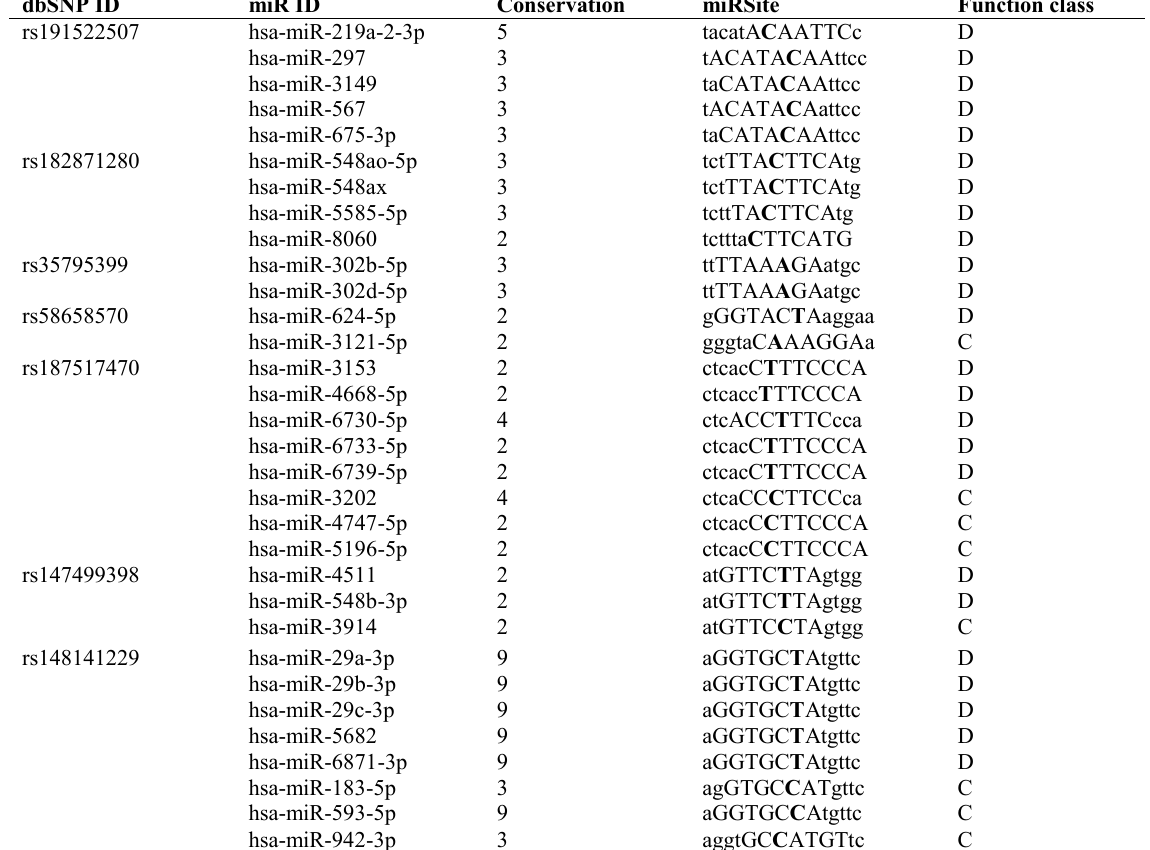
Table 7. Seven functional SNPs that disrupt miRNAs conserved site as predicted by PolymiRTS database. The sequence related to each miRNA site is shown in miRSite. Capital letters represent the complementary bases of the seed region, and SNPs are shown in bold. miR ID Conservation